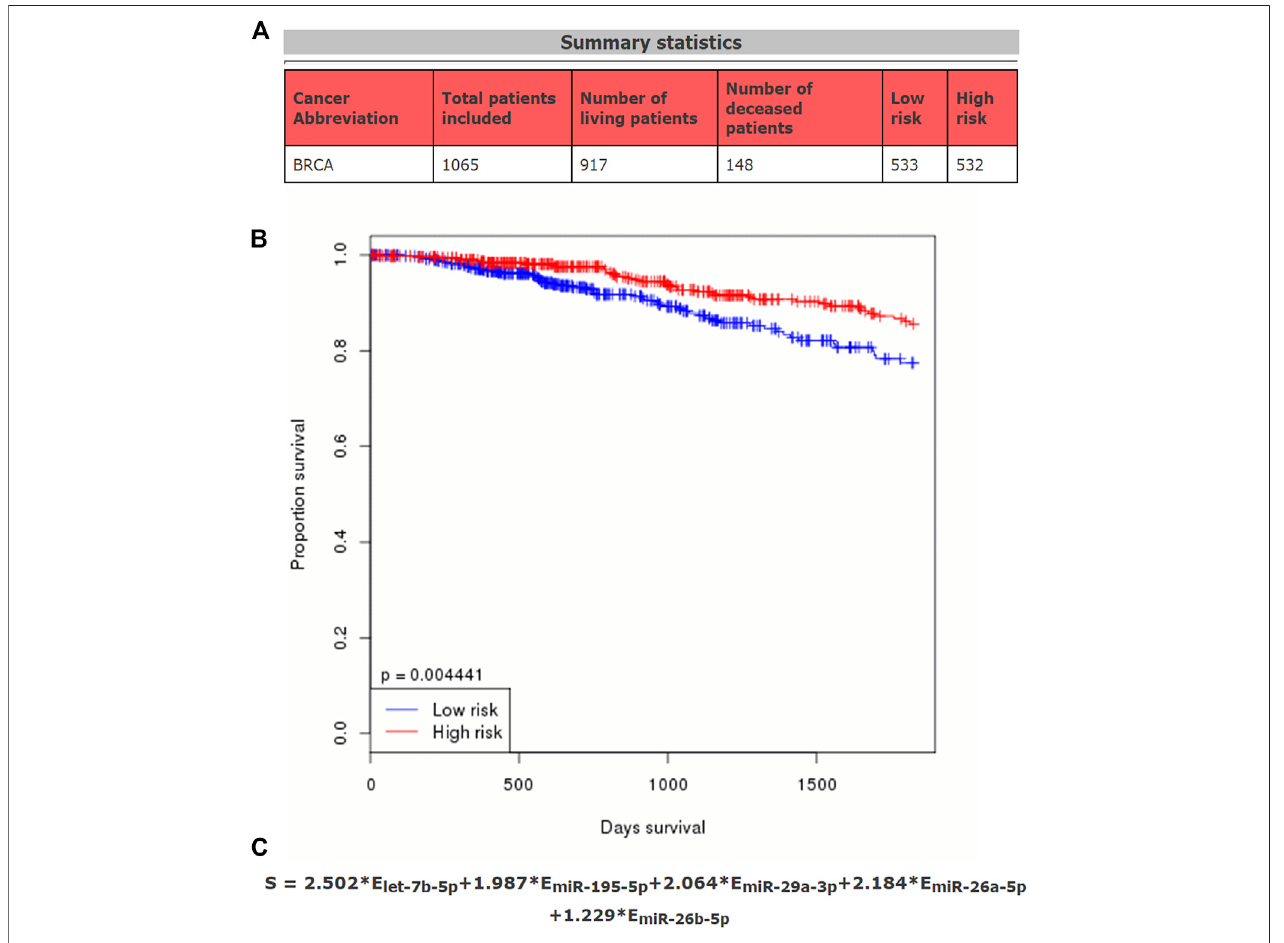
FIGURE3| Establishmentofapotentialprognosticsignaturebasedon fi vemiRNAs(let-7b-5p,miR-195-5p,miR-29a-3p,miR-26a-5p,andmiR-26b-5p)inbreast cancer. (A) Summary statistics of data used in this prediction model. (B) Survival curve of the constructed miRNA signature in breast cancer. According to the median expression of miRNAs calculated by the formula, the total breast cancer patients can be divided into two groups, including high-risk group and low-risk group. (C) Calculating formula of this miRNA prognostic signature.